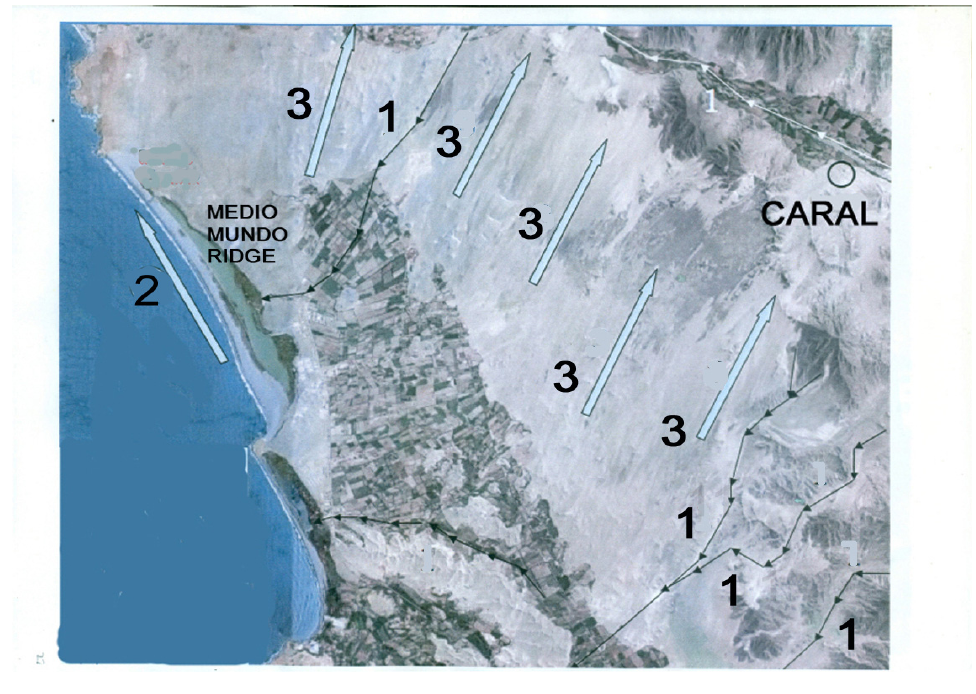
Figure 32. Aeolian sand deposit areas in the Huara valley south of the Supe Valley and urban Caral transferred by constant northeast winds (Google Earth satellite photograph).